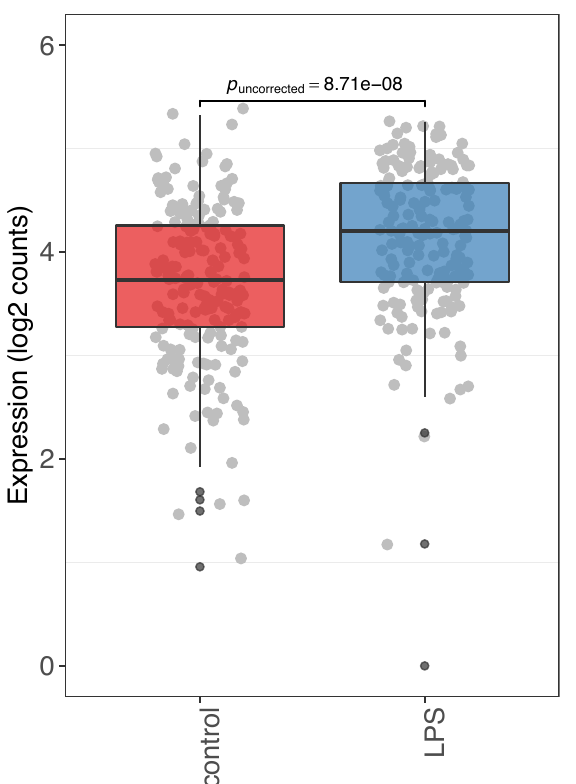
Figure 4. Increment of ERVPb1 mRNA expression in primary monocytes by LPS administration. Comparison of RNA-Seq data from healthy primary and LPS-treated monocytes is